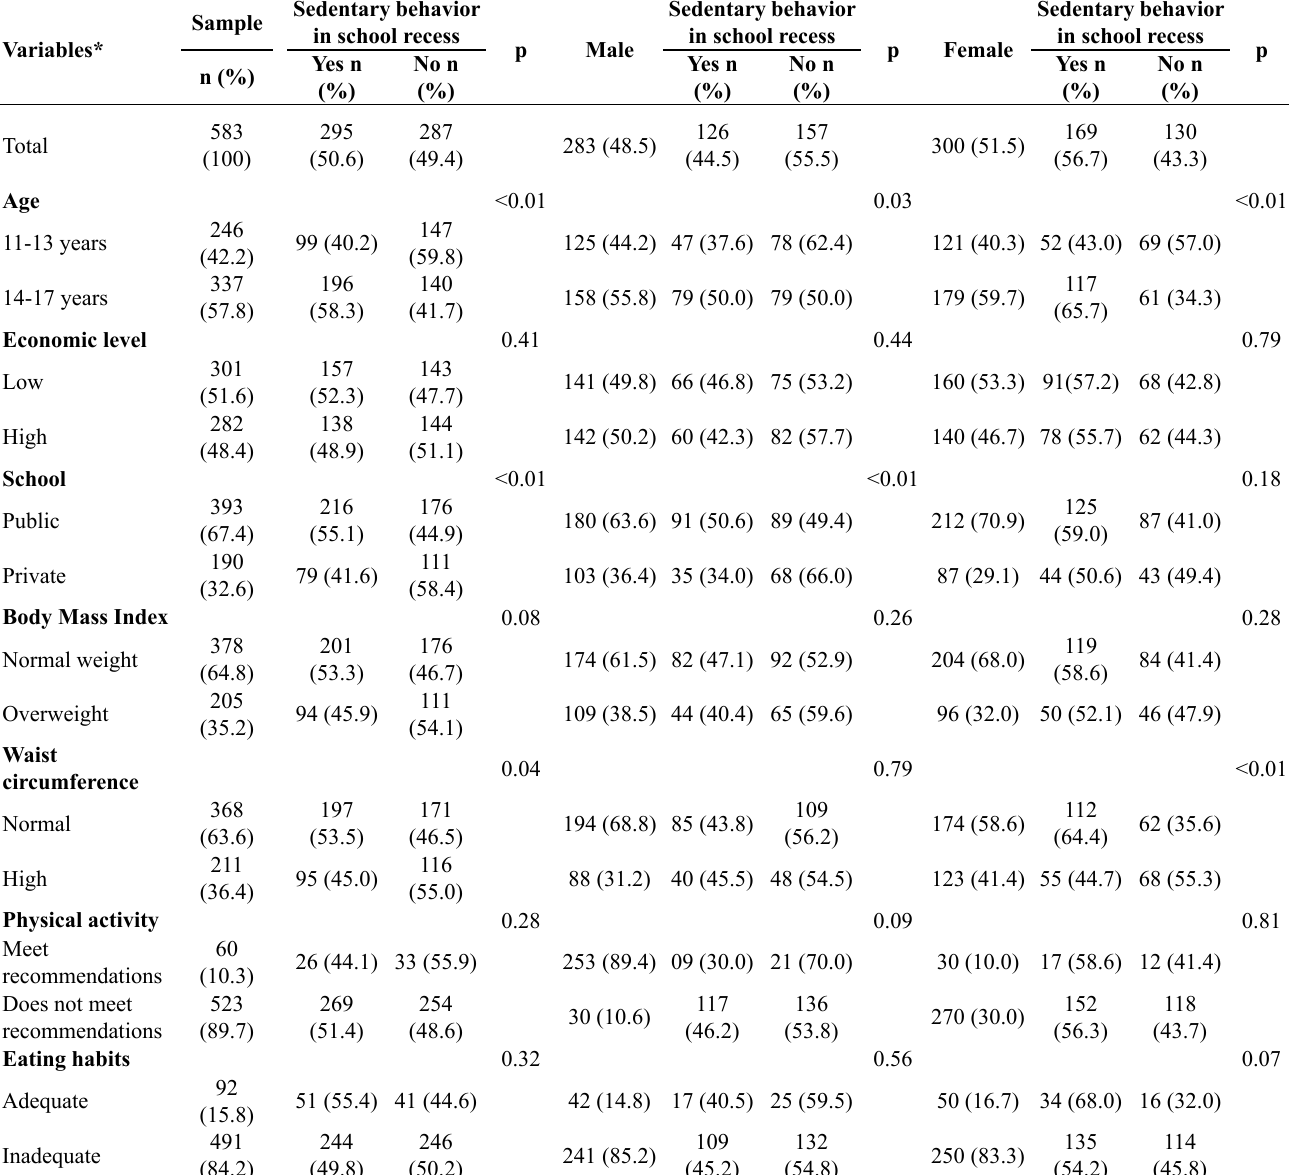
Table 1. Sample distribution according to sedentary behavior during school recess of students, Criciúma, Santa Catarina,